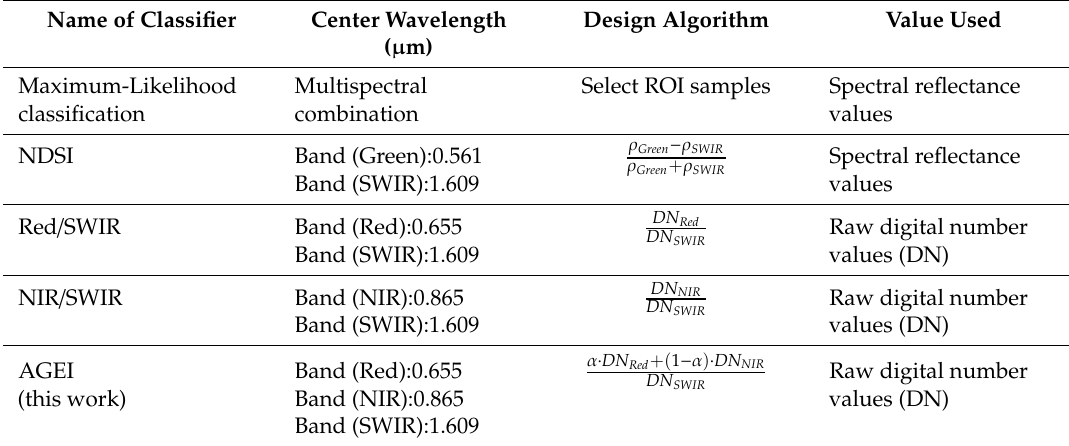
Table 2. Comparison of the information about di ff erent classifiers for glacier